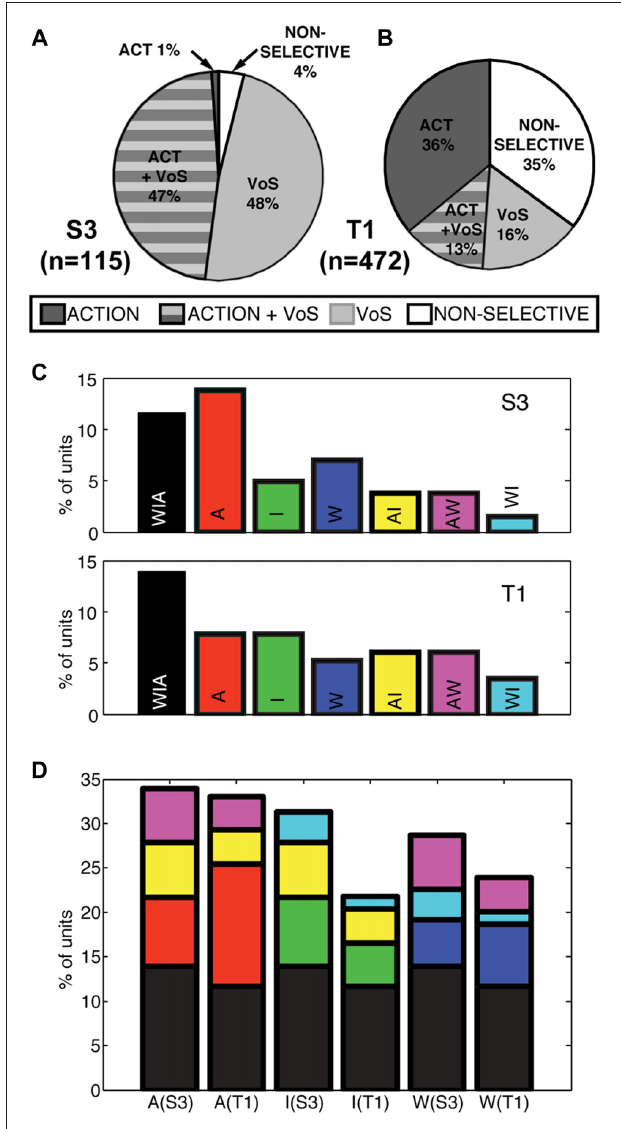
FIGURE 2 | Actions and VoS are encoded by overlapping populations of single units. (A,B) Percentage of neurons displaying information related to VoS (watch, imagine, or attempt) or action (different movement) conditions in each participant (SSIMS analysis, see “Materials and Methods” section). The proportion of VoS related neurons is lower in T1, despite similar percentages of action related neurons. (C) Classes of action-related neurons, depending on engagement across W, I, A conditions (for example, yellow bars represent AI neurons, which displayed different activity patterns for movements aimed at different targets in both A and I). (D) Same bars and color scheme as in (C) , but with the bars stacked according to the types of neurons engaged in each VoS (separated by participant). The height of each bar represents the total percentage of action-related neurons recorded in each condition. Note that some of the stacked bars are shown more than once (for example, purple AW neurons are counted for both A and W